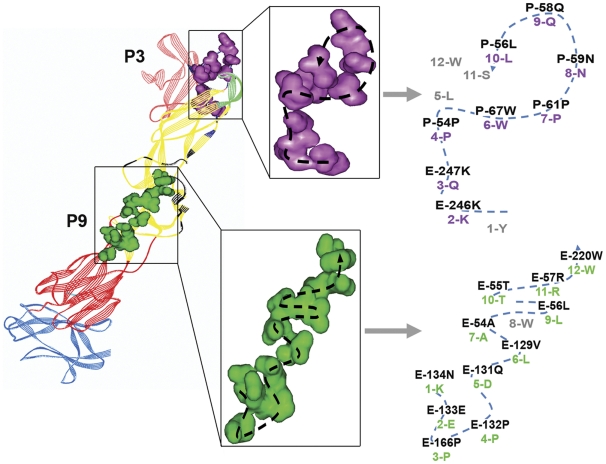
Localization of P3 and P9 peptide sequence on 3D crystal structure of prM-E heterodimer (PDB 3C6E).P3 (Purple) and P9 (green) peptide sequences were aligned with the predicted clusters (Cluster 1 – Navy blue; Cluster 2 – Black) on the prM-E crystal structure. The path of peptide phage sequences was highlighted with the participating residues from the cluster and the peptide phage labeled. Matched residues were purple (P3) or green (P9) and numbered accordingly; mis-matched residues were grey. The respective proteins and domains were highlighted as above.